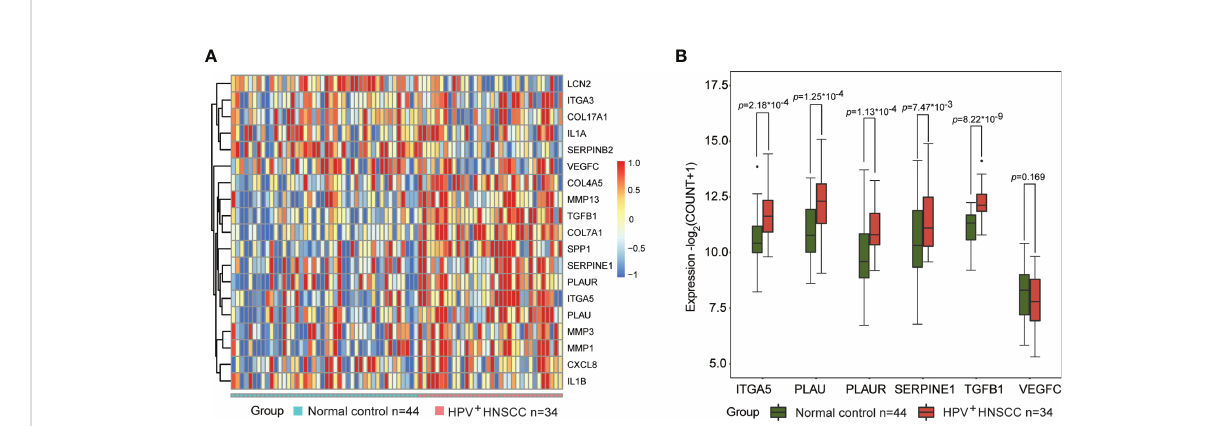
FIGURE 8 Biomarkers are involved in the transformation and progression of head and neck squamous cell carcinoma (HNSCCs) in patients with human papillomavirus (HPV) infection. (A) Expression patterns of 19 differentially expressed genes (DEGs) in HPV-positive HNSCCs ( n = 34) and normal controls ( n = 44) visualized as heatmaps. (B) Expression levels of ITGA5 , PLAU , PLAUR , SERPINE1 , TGFB1 , and VEGFC in HPV-positive HNSCCs ( n = 34) and normal tissues ( n = 44). * means